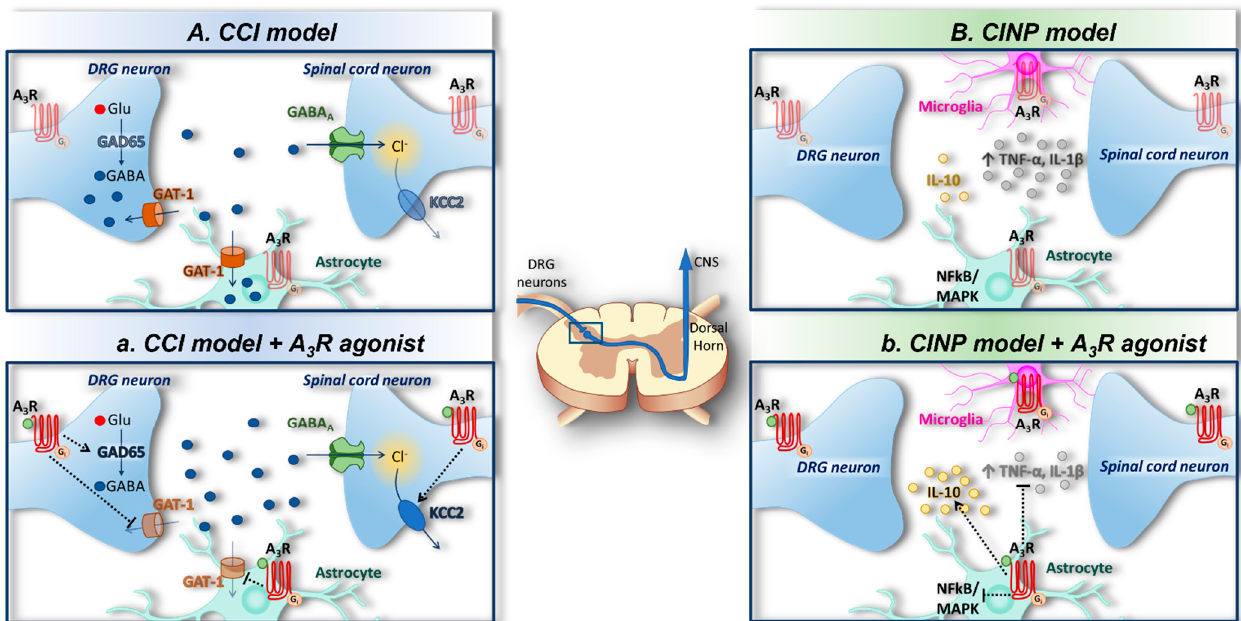
Figure 2. Adenosine A 3 receptors and spinal mechanisms of pain control. ( A ) Chemotherapy-induced neuropathic pain (CINP) is characterized by high neuroexcitatory/proinflammatory cytokine (TNF- α and IL-1 β ) release and the activation of NF κ B and MAPK in the spinal dorsal horn. ( a ) Glial A 3 Rs inhibit NF κ B and MAPK activation, thus leading to a decreased release of pro-inflammatory TNF- α and IL-1 β and an increased release of anti-inflammatory interleukin-10 (IL-10) [52]. ( B ) Chronic constriction injury (CCI), an animal model of neuropathic pain, induces deregulation of γ -aminobutyric acid (GABA) signaling via a reduction in GABA synthesis by glutamic acid decarboxylase 65-kDa (GAD65), and enhanced GABA reuptake via the GABA transporter 1- (GAT-1) and the loss of Cl − gradient by K + -Cl − co-transporter 2 (KCC2) inhibition, leading to an overall reduction in GABA at the synapse. ( b ) A 3 receptor (A 3 R) activation prevents CCI-induced GAT-1 enhancement and GAD65 inhibition as well as KCC2 loss of function [51], augmenting extracellular GABA levels.